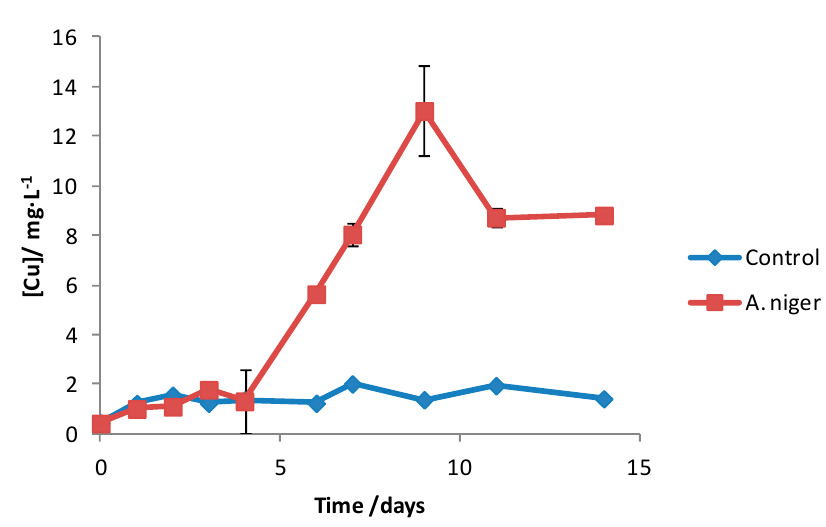
Figure 3 . Evolution of copper concentration from turquoise (1 g/L) in abiotic and biotic ( A. niger ) Figure 3. Evolution of copper concentration from turquoise (1 g / L) in abiotic and biotic ( A. niger ) tests.